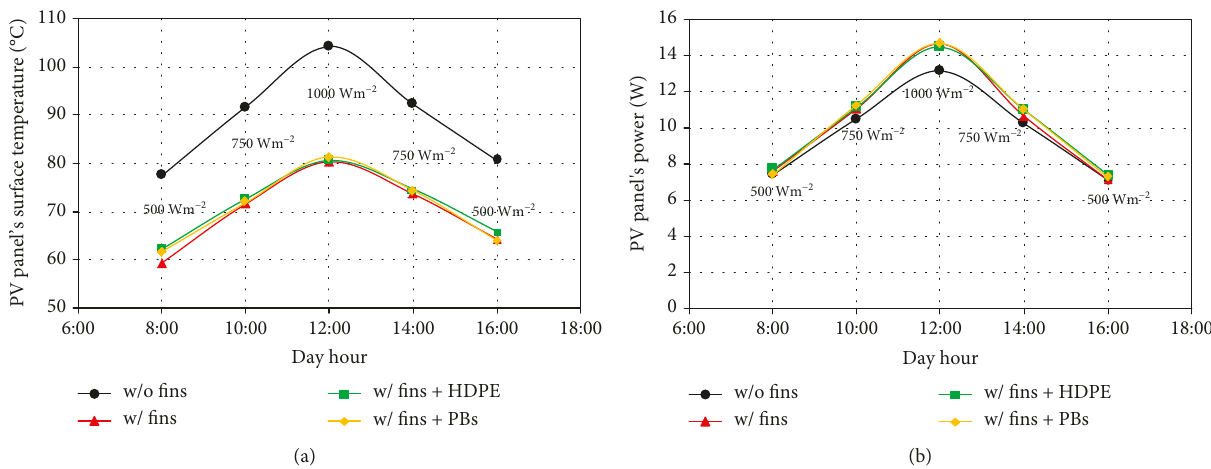
Figure 6: Comparison of results for the as-is PV panel and the PV panel modi fi ed using fi ns, fi ns+HDPE, and fi ns+PBs for (a) a PV panel ’ s surface temperature and (b) a PV panel ’ s output